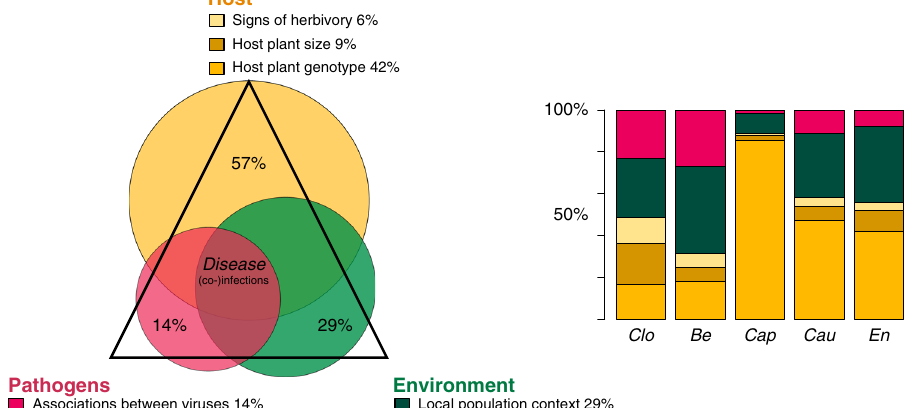
Fig. 4 Partitioning of the variance explained by model variant 2 (Table 1). The diagram overlays the average proportions (over species) of variance explained by different groups of explanatory variables (out of the total variation explained by the model) and the concept of the disease triangle. The legend labels denote the different variables for which the partitioning is calculated, and the percentages indicate the mean values for the whole community. The barplot gives these results separately for each virus: the horizontal axis shows the focal fi ve viruses (ordered from left to right according to their decreasing overall infection rate) and the vertical axis shows the proportion of variance explained. ‘ Clo ’ refers to Plantago closterovirus , ‘ Be ’ to Plantago betapartitivirus , ‘ Cap ’ to Plantago lanceolate latent virus , ‘ Cau ’ to Plantago latent caulimovirus , and ‘ En ’ refers to Plantago enamovirus . Table 2 Regression coef fi cients for model variant 2 for each virus species.